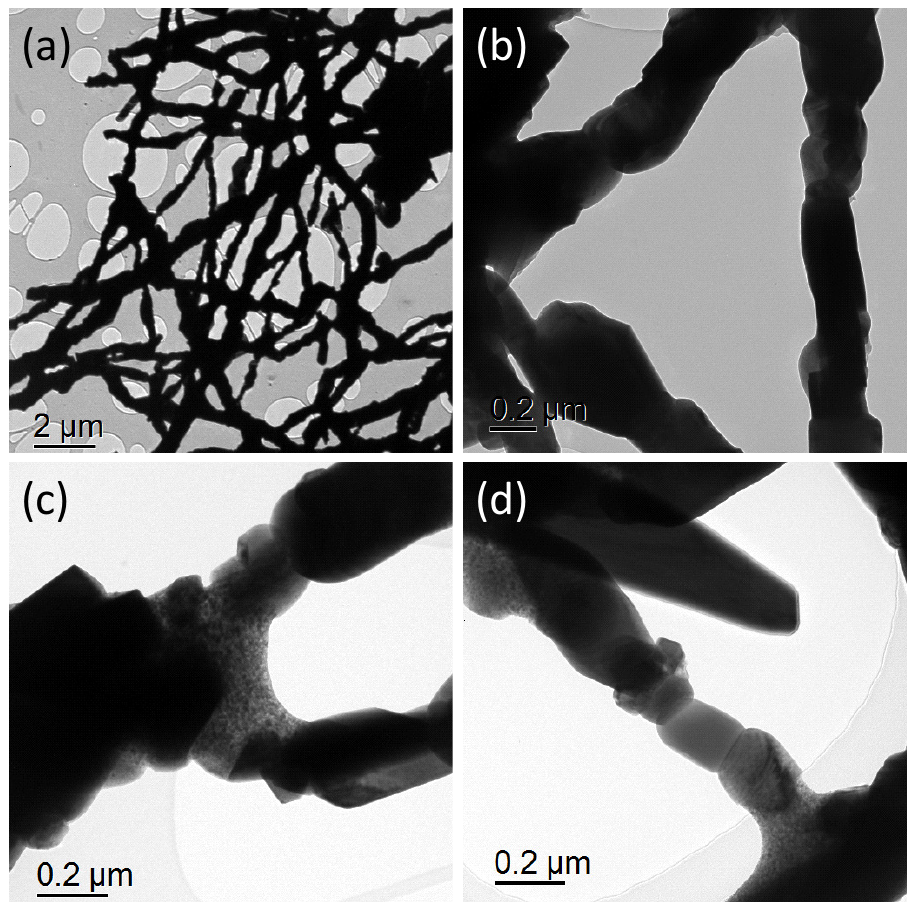
Figure 4. TEM images of the Bi-2212 nanowires. ( a ) presents a low-magnification image of a section with many interconnects beteen the nanowires. ( b , c ) Details of the nanowires revealing the building-up of the nanowire. ( d ) shows a case where a nanowire is formed by a single Bi-2212